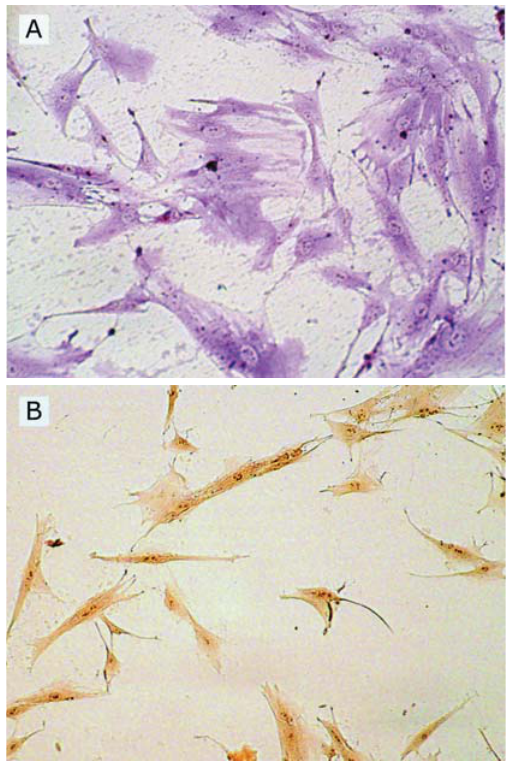
Fig. 2 - Fotomicrografia mostrando células aderentes provenientes do sangue de cordão umbilical. A. Análise citoquímica mostrando células mesenquimais marcadas positivamente pelo reativo ácido de Schiff (PAS). B. Análise citoquímica mostrando